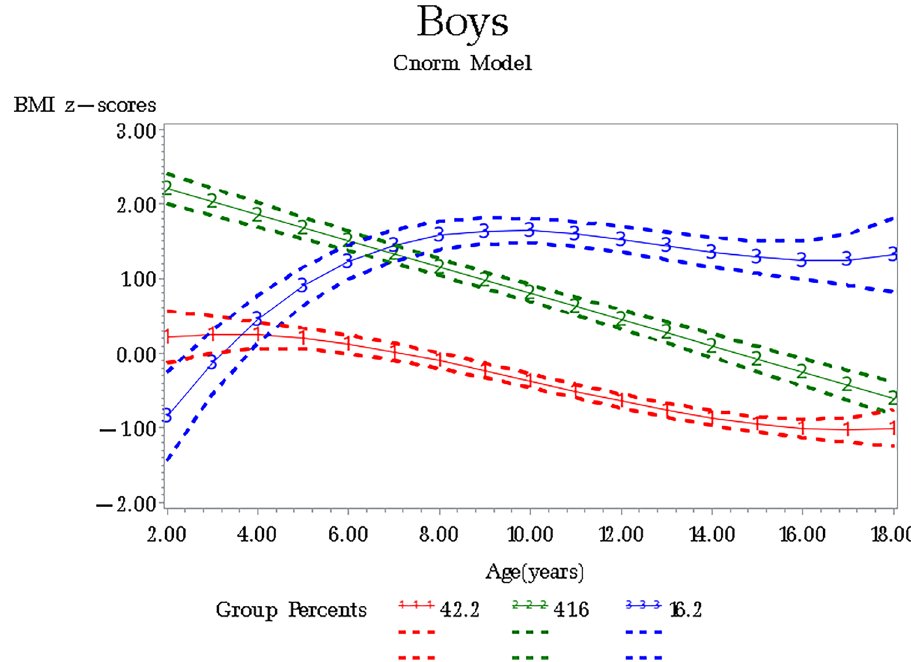
Figure 1. BMI z-scores trajectory groups among boys aged from 2 to 18, CFPS.